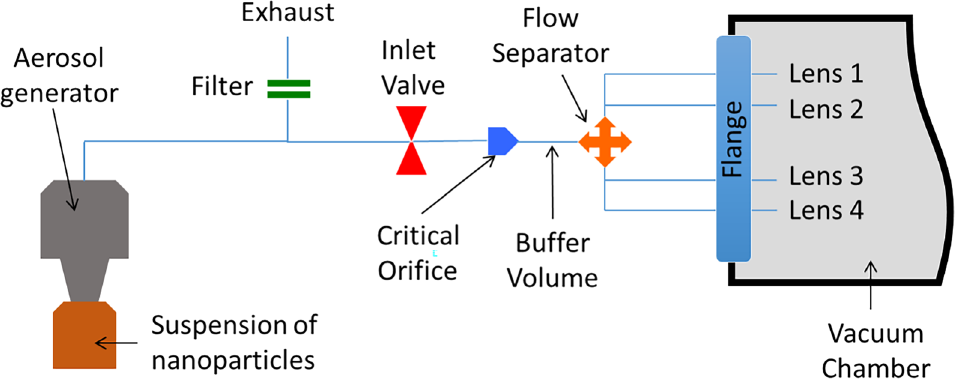
Figure 10. Scheme of the transport of the nanoparticles from the aerosol generator to the four aerodynamic lenses.